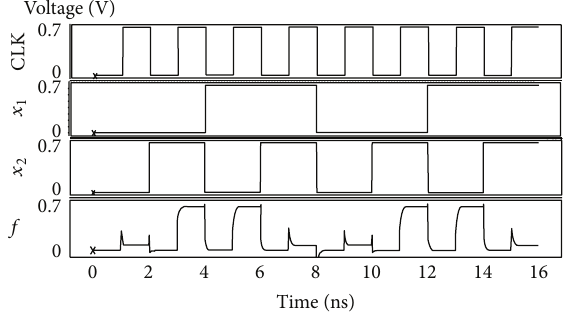
Figure 3: Transient waveforms of the proposed